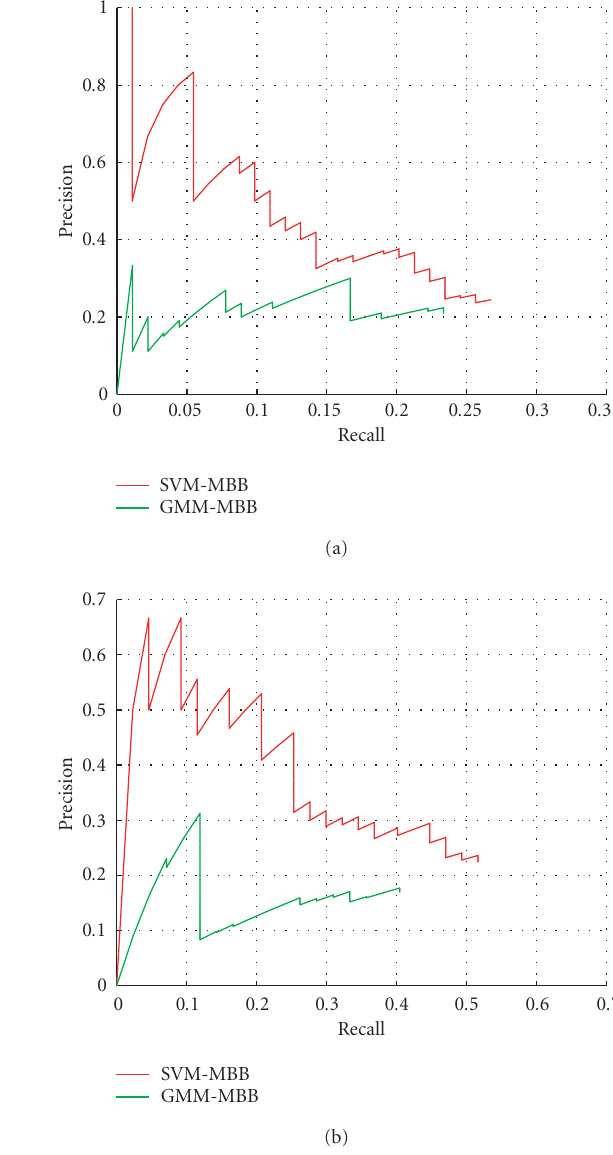
Figure 6: Precision-recall comparison between SVM and GMM (a) Rocket object (b)